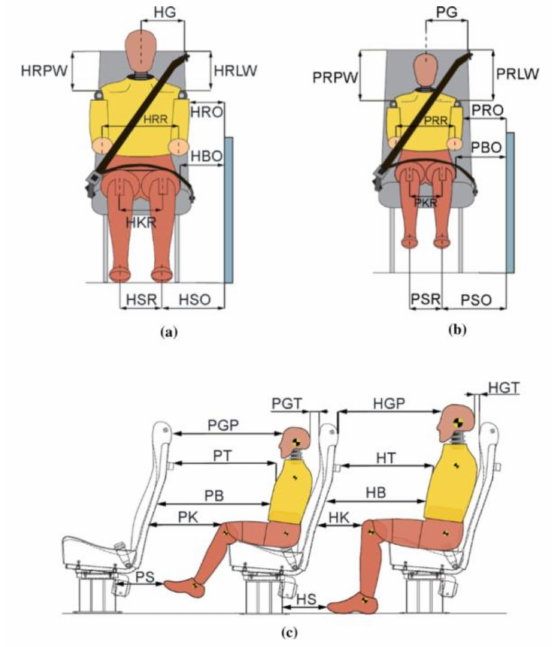
Figure 2. Dimensions describing the dummy position concerning the seat and safety belt location: